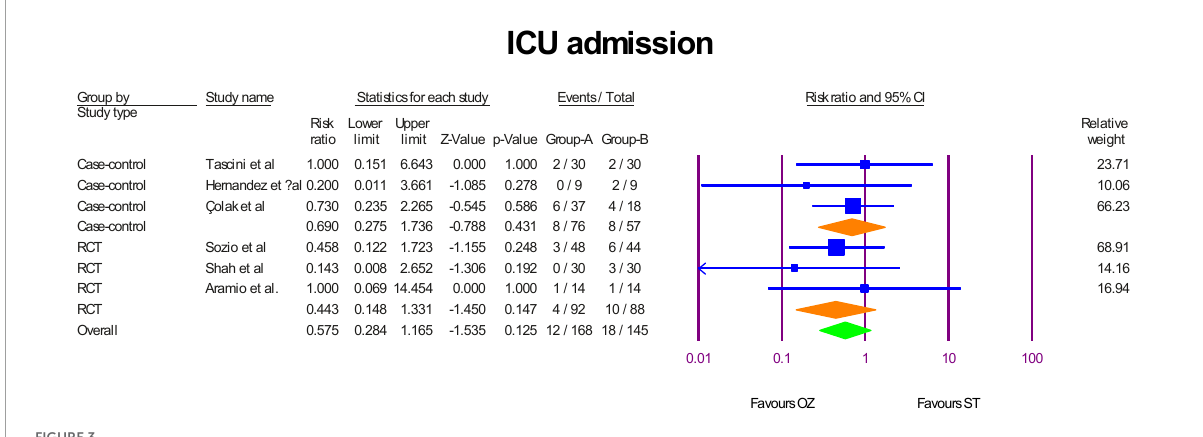
FIGURE3 A forest plot of ICU admission based on study type in the OZ group compared to the ST group (Group A = OZ, Group B = ST).